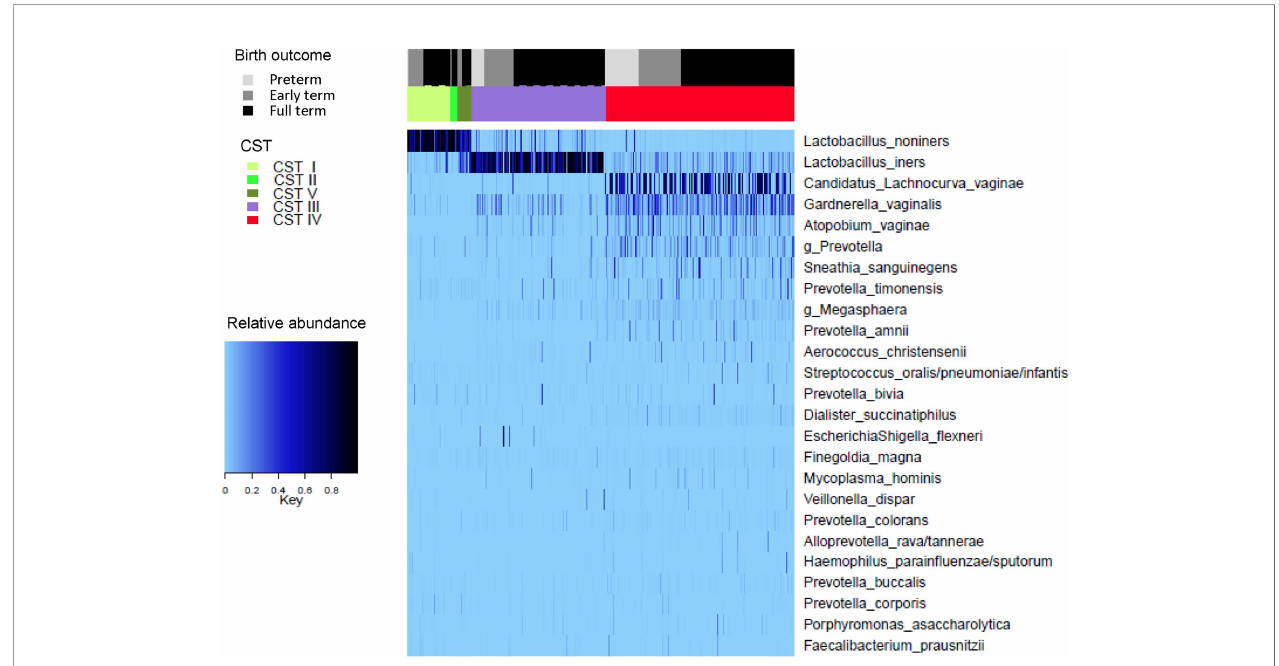
FIGURE 3 | Top 25 taxa, grouped according to Community State Type (CST) and Gestational age at birth